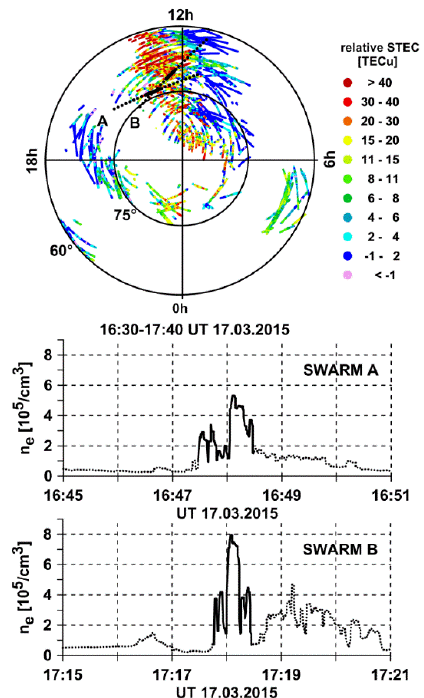
Figure 5. The signatures of patches derived from GNSS and SWARM measurements. The top panel presents the distribution of relative STEC values as a function of magnetic local time (MLT) and AACGM latitude with two superimposed arcs of SWARM depicted with black dotted and solid lines. The bottom panel presents the corresponding temporal profiles of SWARM foreground plasma density. The strong enhancements of plasma density are marked with a solid black line in both panels.